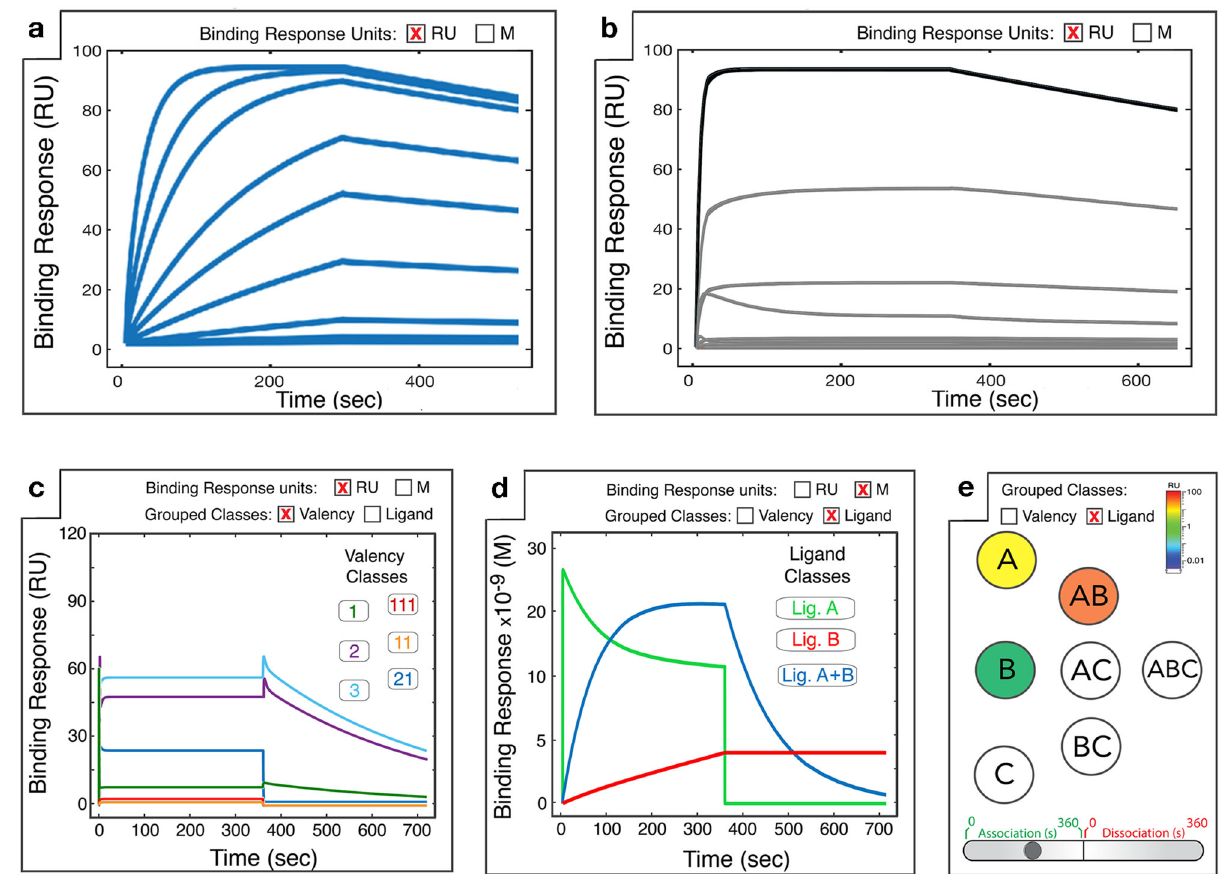
c , d To facilitate analyses of the binding responses, the microstates can be binned according to either c valency or d ligand class. e For visual analysis of the evolution of a network of microstates in b , an interactive graph shows population changes in microstate classes over a timecourse of association and dissociation. The simulations in these fi gure panels are not related to one another; they are for illustrative purposes to highlight the distinctive features in each view. Tutorials illustrating the output interfaces and features are available in the Supplementary Information and at https://sarkarlab.github.